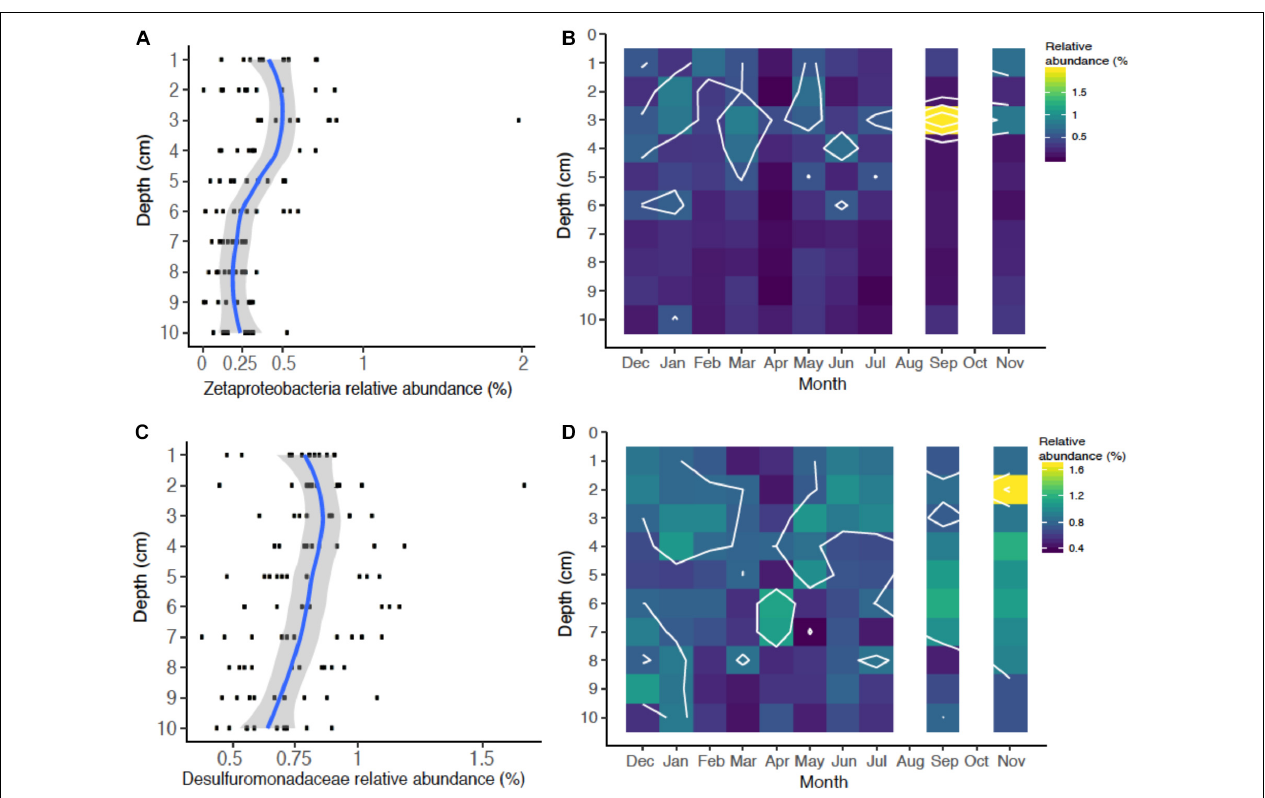
FIGURE 4 | Relative abundance of iron cycling operational taxonomic units (OTUs) identified over the season: Iron-oxidizing Zetaproteobacteria (OTU00040) relative abundance as a function of depth (A) and season (B) , and putative iron-reducing Desulfuromondaceae (OTU00028) as a function of depth (C) and season (D)